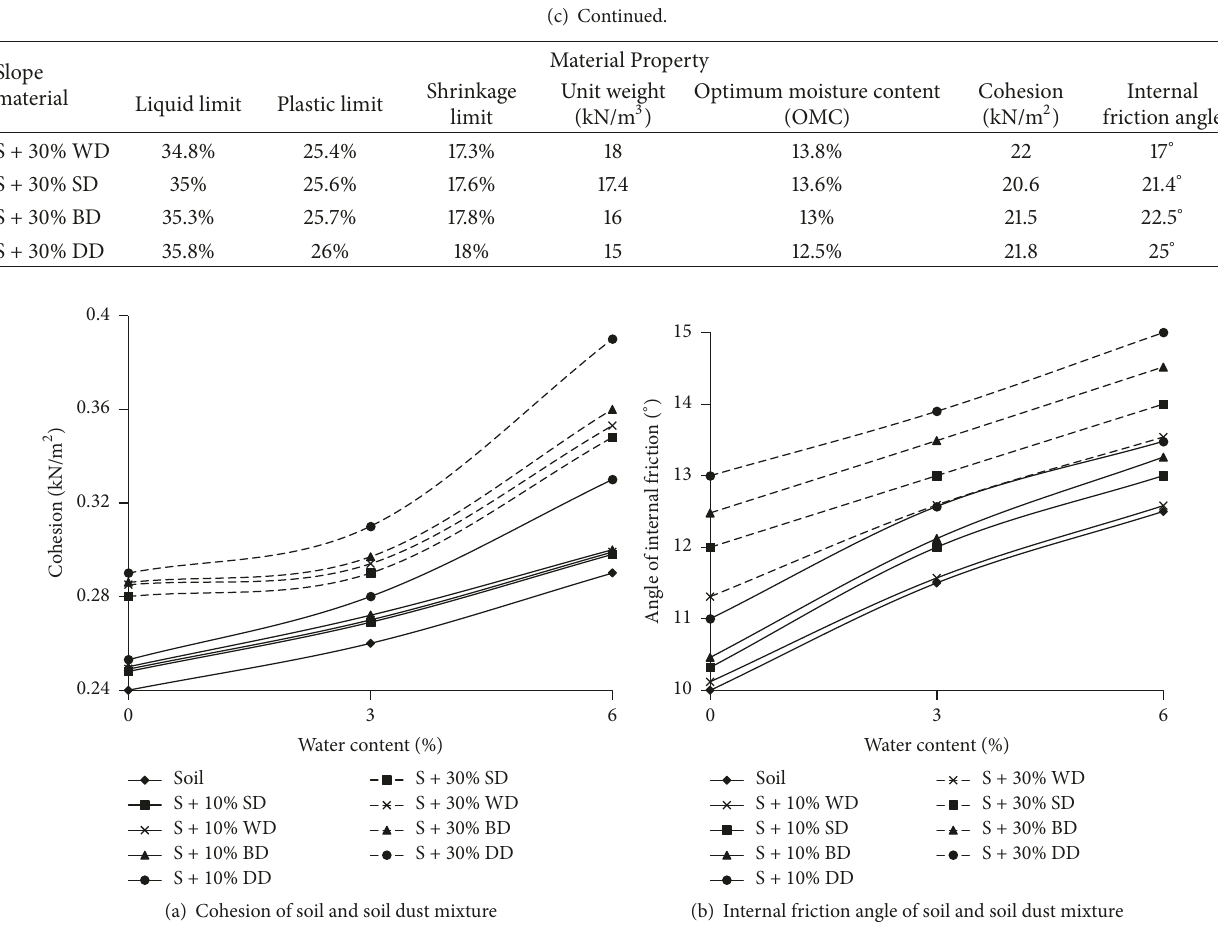
Figure 4: Shear strength parameters of soil and soil dust mixtures at different water